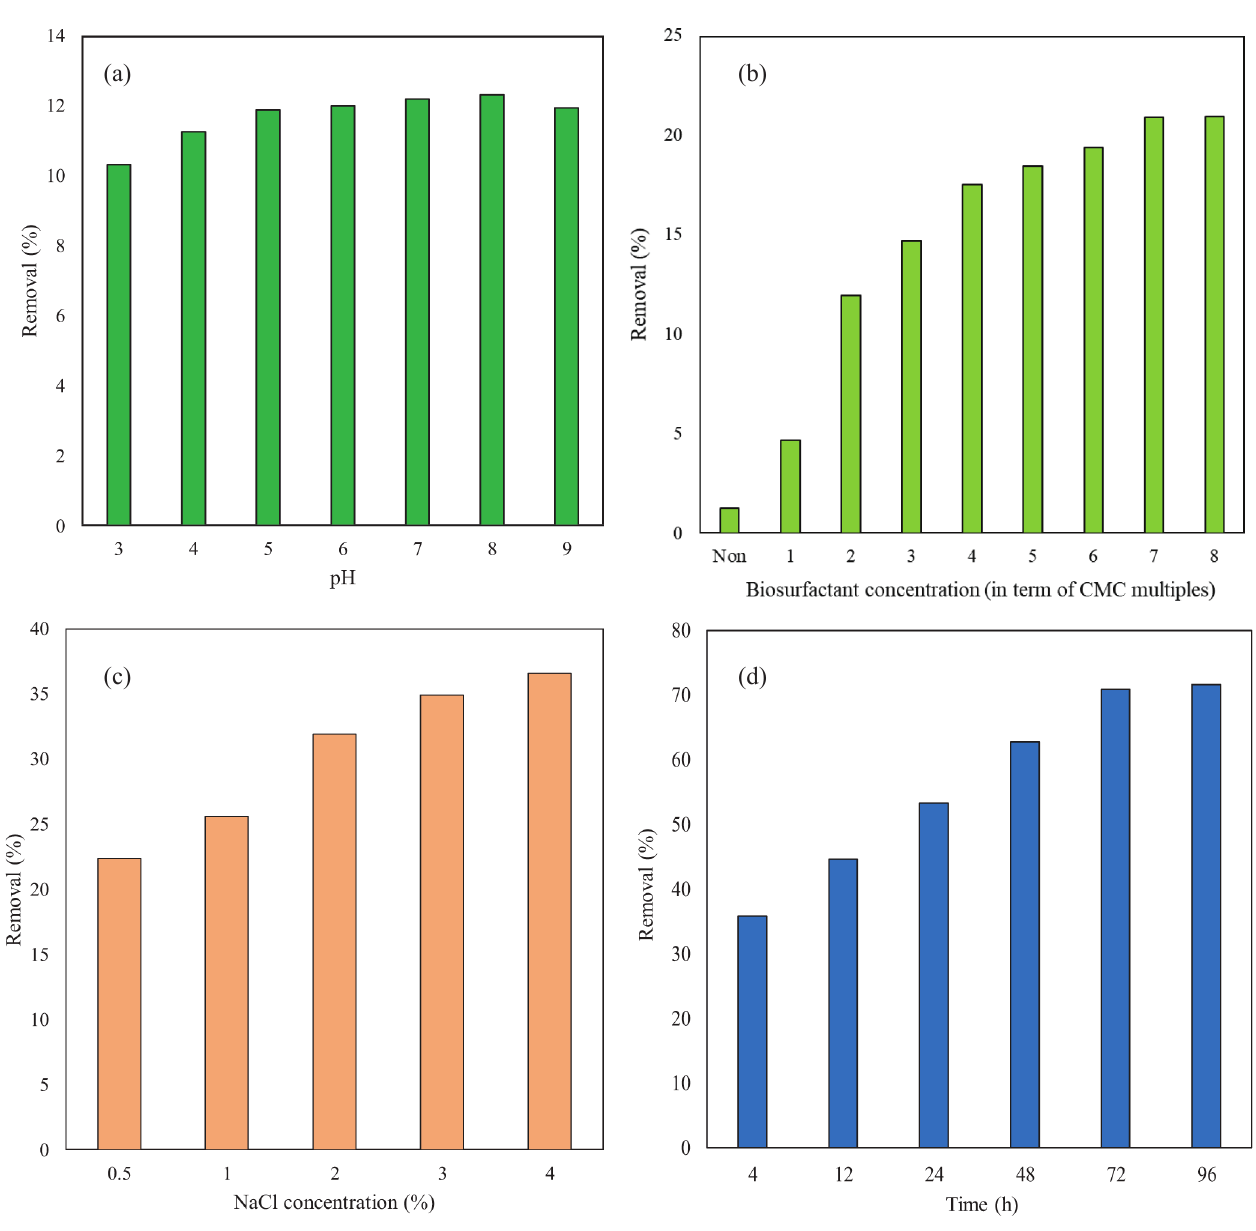
Fig. 7 – Effects of operating parameters on PAHs desorption from contaminated soil; a) effect of pH (contact time 4 h, concentra­ tion = 2 CMC), b) effect of concentration (pH = 7.0, contact time 4 h), c) effect of salinity (pH = 7.0, concentration = 7 CMC, contact time 4 h), and d) effect of contact time (pH = 7.0, concentration = 7 CMC, NaCl = 4